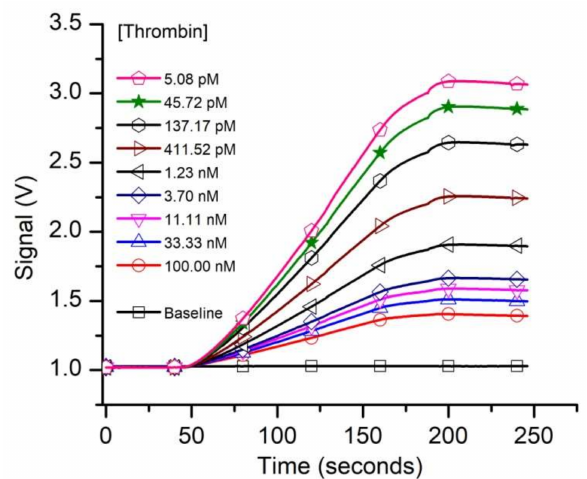
Figure 3. The evolution of the raw fluorescence signal recorded from capturing the free FA left in solutions equilibrated with various thrombin concentrations. The free FA availability decreased as the titrant concentration in the samples increased. For this experiment we utilized 50 pM FA as constant binding partner